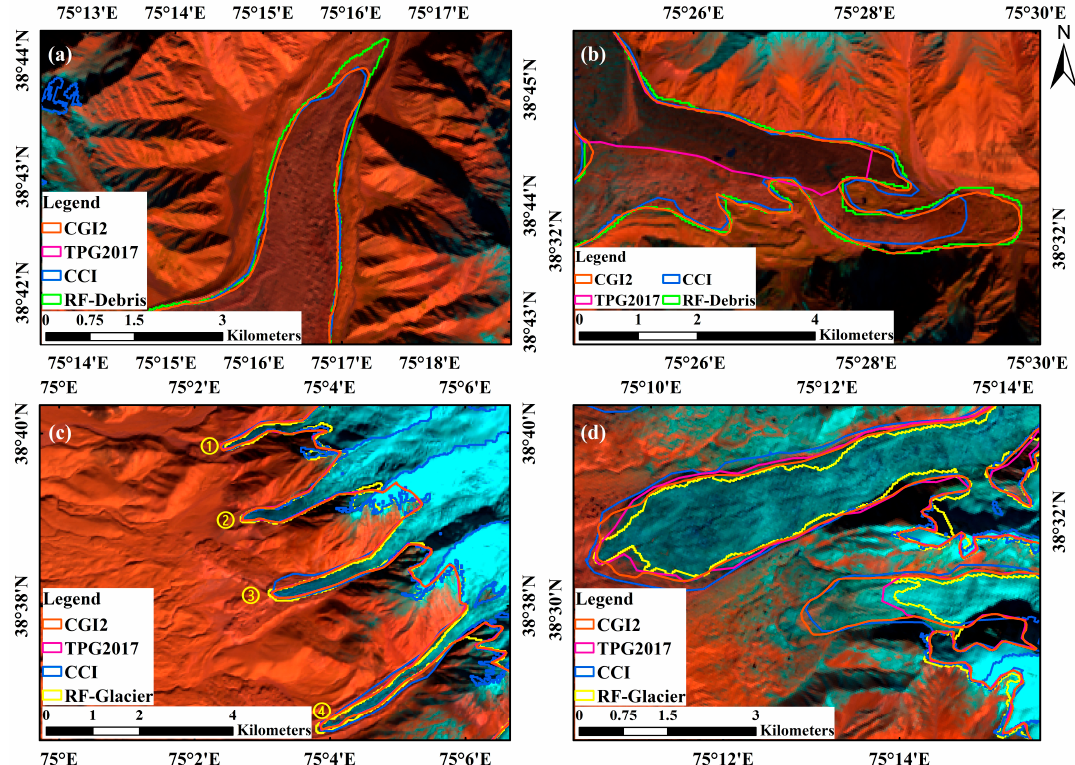
Figure 15. ( a – d ) Results of the Random Forest classification (yellow lines) compared with those of the three inventories CGI (orange lines), TPG2017 (rose red lines) and CCI (blue lines) with a false color band combination image acquired 20 October 2017, R = shortwave infrared band (band 6), G = near-infrared band (band 5) and B = blue band (band